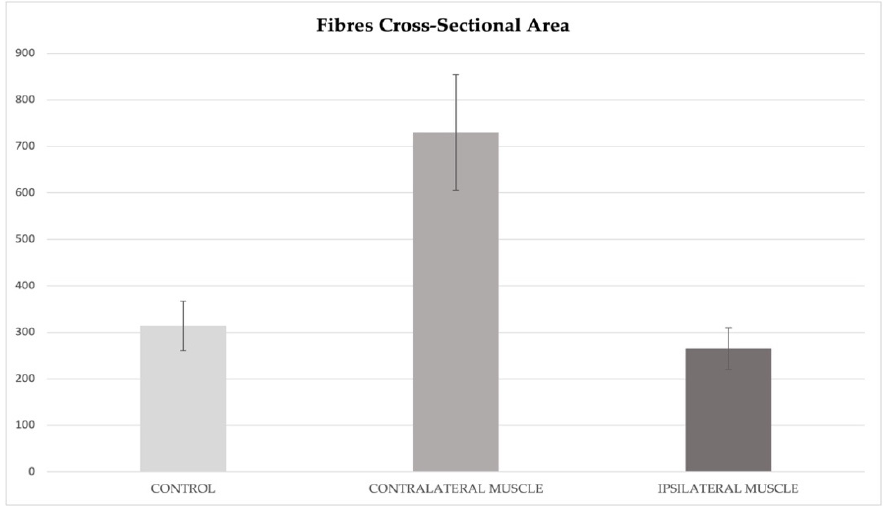
Figure 3. Histogram showing the mean values of fibers cross-sectional area in the control, contralateral and ipsilateral muscles: the means were 314 μ m 2 , 730 μ m 2 , and 265 μ m 2 , respectively. The bar error corresponds to the standard deviation. The differences are statistically significant in the following comparisons: control–contralateral with a p -value = 0.02 and contralateral–ipsilateral with a p -value = 0.01. The difference between the control and ipsilateral is not statistically significant with a p -value = 0.1.